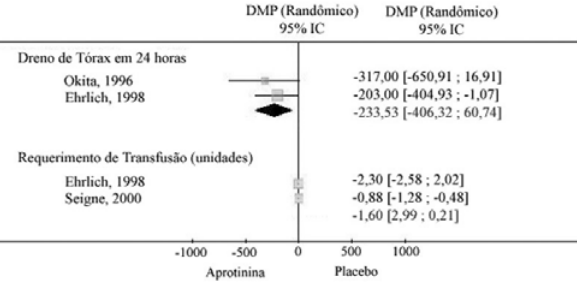
Fig. 5 - Metanálise das variáveis contínuas dos estudos que administraram baixa dose de aprotinina. DMP = diferença de média ponderada; IC = intervalo de